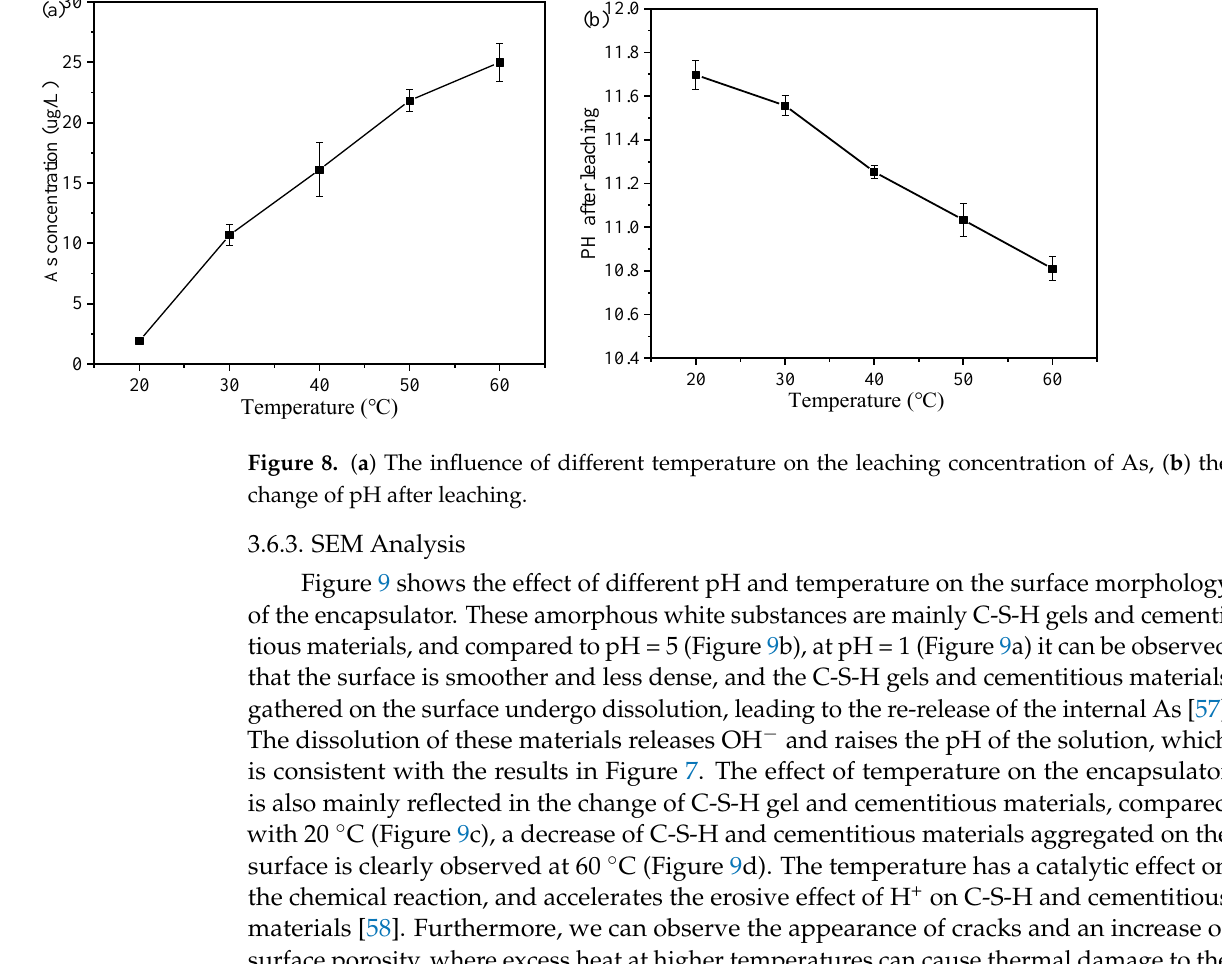
Figure 9. SEM images different pH and temperature: ( a ) pH = 1; ( b ) pH = 5; ( c ) temperature = 20 °C; ( d ) temperature = 60 °C.